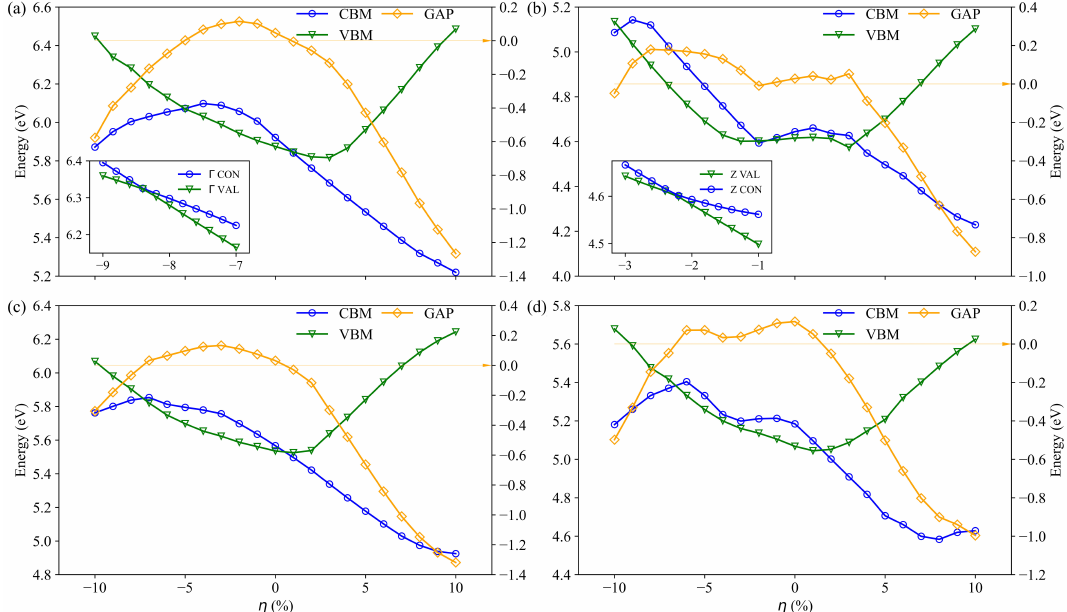
Figure 5. Evolution of CBM and VBM energies, and energy gap of Bi 2 Te 3 ( a ), PbBi 2 Te 4 ( b ), PbBi 4 Te 7 ( c ) and Pb 2 Bi 2 Te 5 ( d ) with respect to strain. The inset in ( a ) represents the CBM and VBM at the Γ point for Bi 2 Te 3 and that in ( b ) represents the CBM and VBM at the Z point for PbBi 2 Te 4